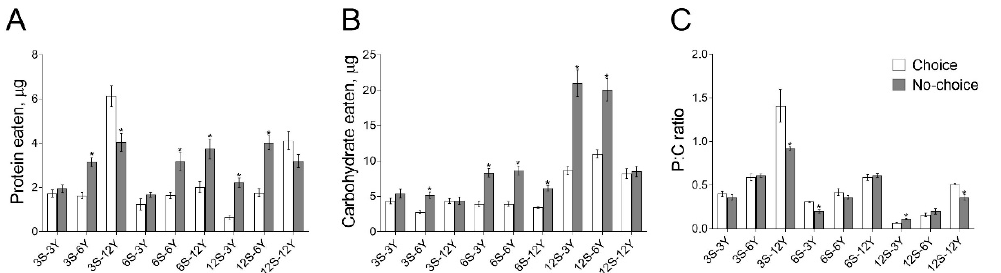
Figure 2. Effects of dietary choice on food consumption. The amount of carbohydrate ( A ) and protein ( B ) intake, as well as protein-to-carbohydrate (P:C) ratio of consumed nutrients ( C ) under choice and no-choice conditions. Data presented as mean ± S.E.M., values considered significantly different if p < 0.05 and marked with *. The legend in the subfigure ( C ) also apply to A and B.